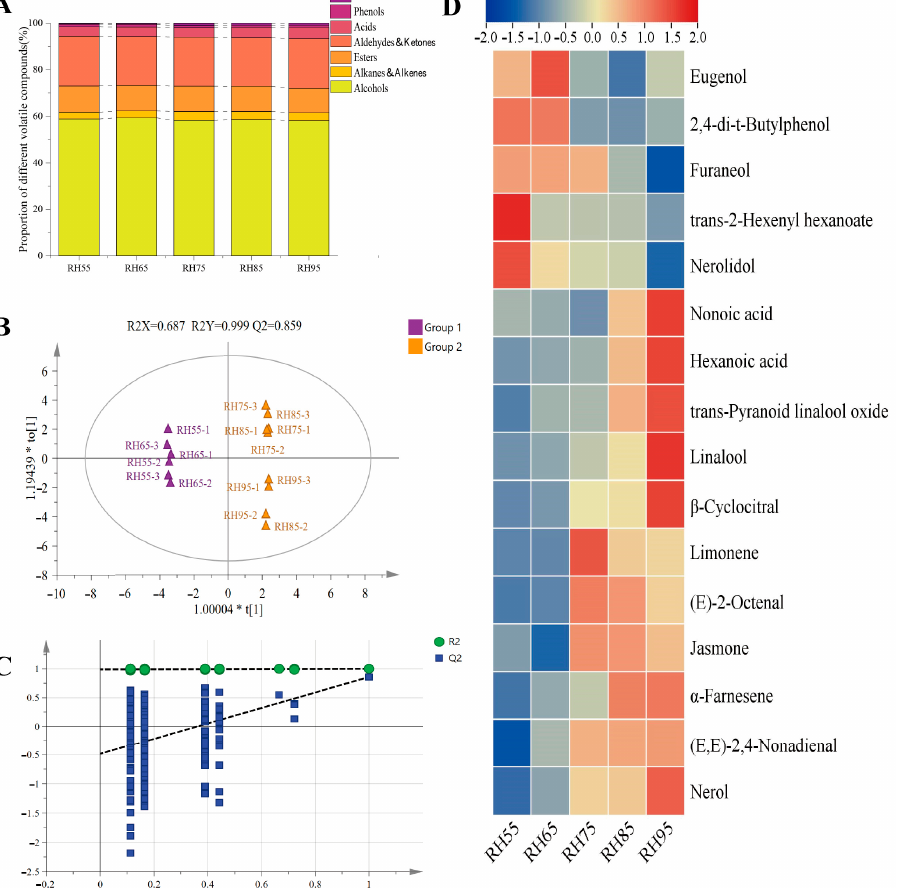
Figure 5. Proportion of di ff erent volatile species in the samples ( A ), OPLS-DA score plot of black tea with di ff erent humidity treatments ( B ), permutation test of black tea with di ff erent humidity treatments ( C ), and cluster heat map of variant aroma components of black tea under di ff erent fermentation humidity conditions ( D ).